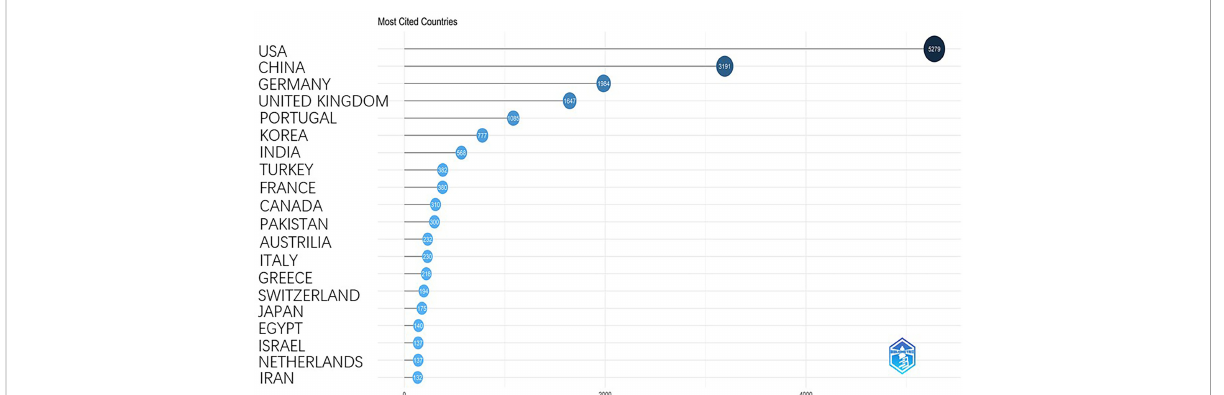
Figure 7 indicated that the top 10 journals out of 398 journals were the main sources of publications in the research fi eld. Our results also indicate that journals with relatively higher impact factor tend to publish more articles, such as Neuro-